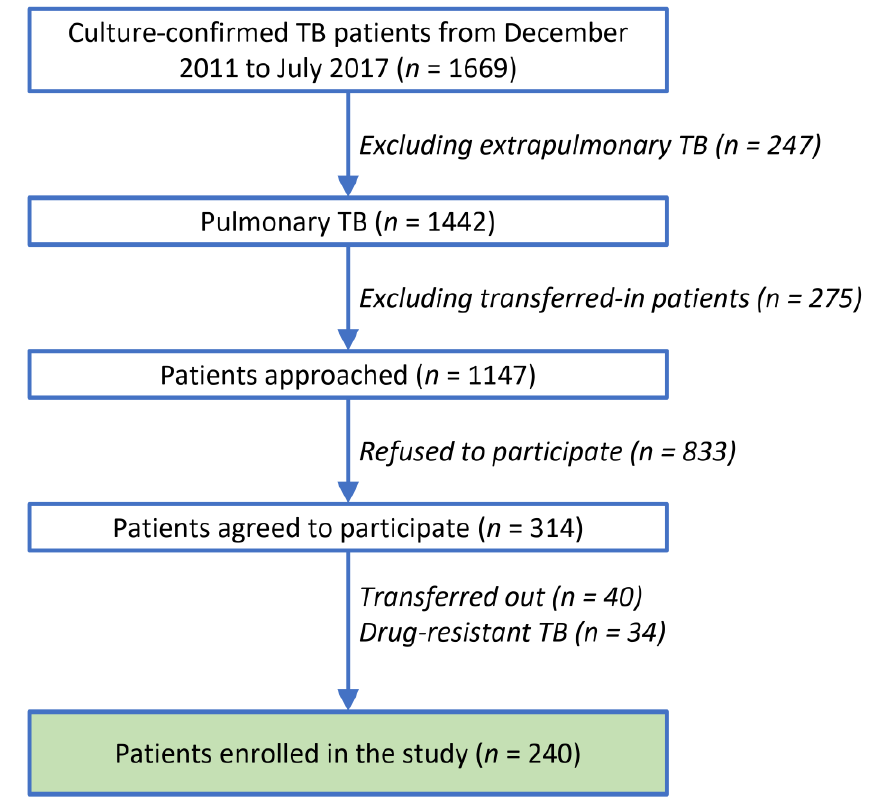
Figure 1. Patient flowchart. Table 1. Characteristics of patient